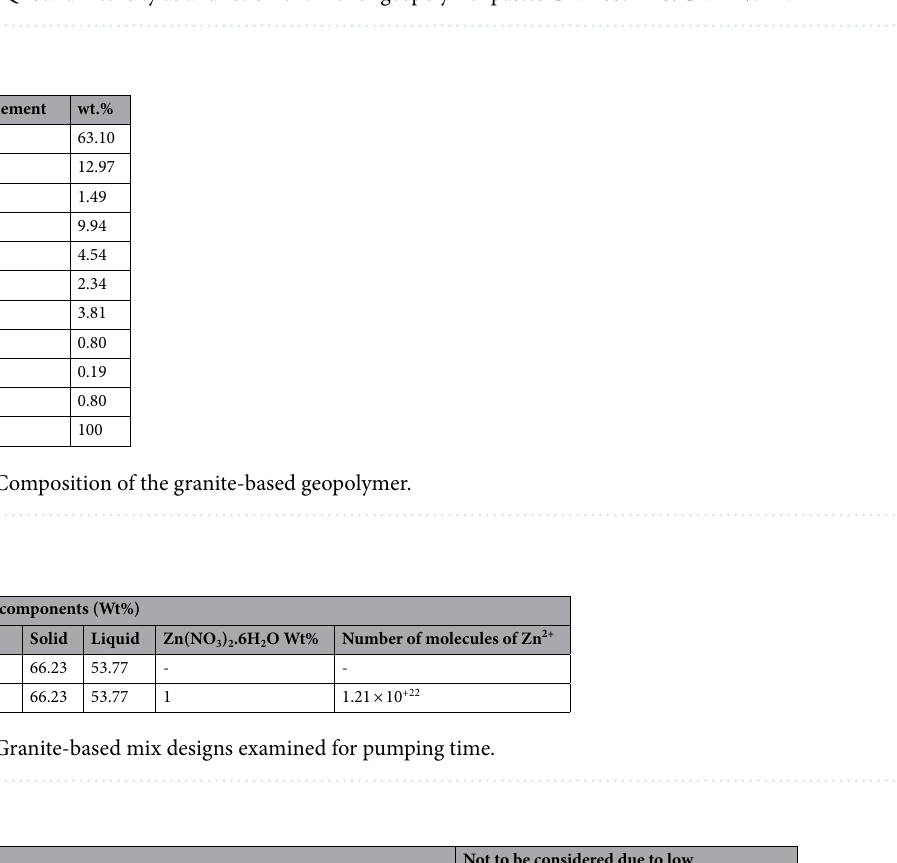
Figure 4. Q 3 band intensity as a function of time for geopolymer pastes CNT-0%Zn & CNT-1%Zn.